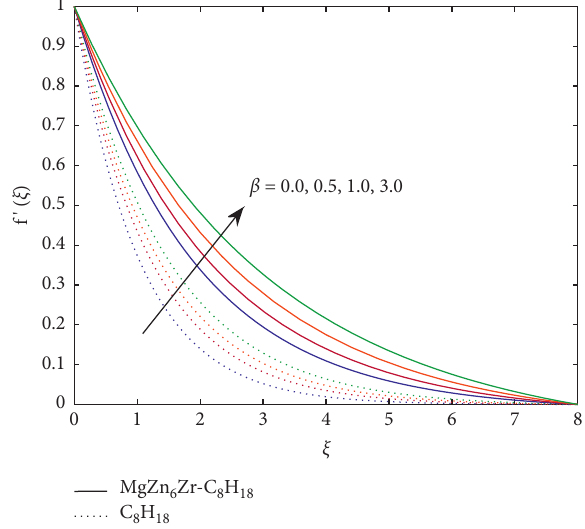
Figure 4: Axial velocity and its comparison in the flow of Zr − C H and C H via β MgZn 8 18 8 18 6